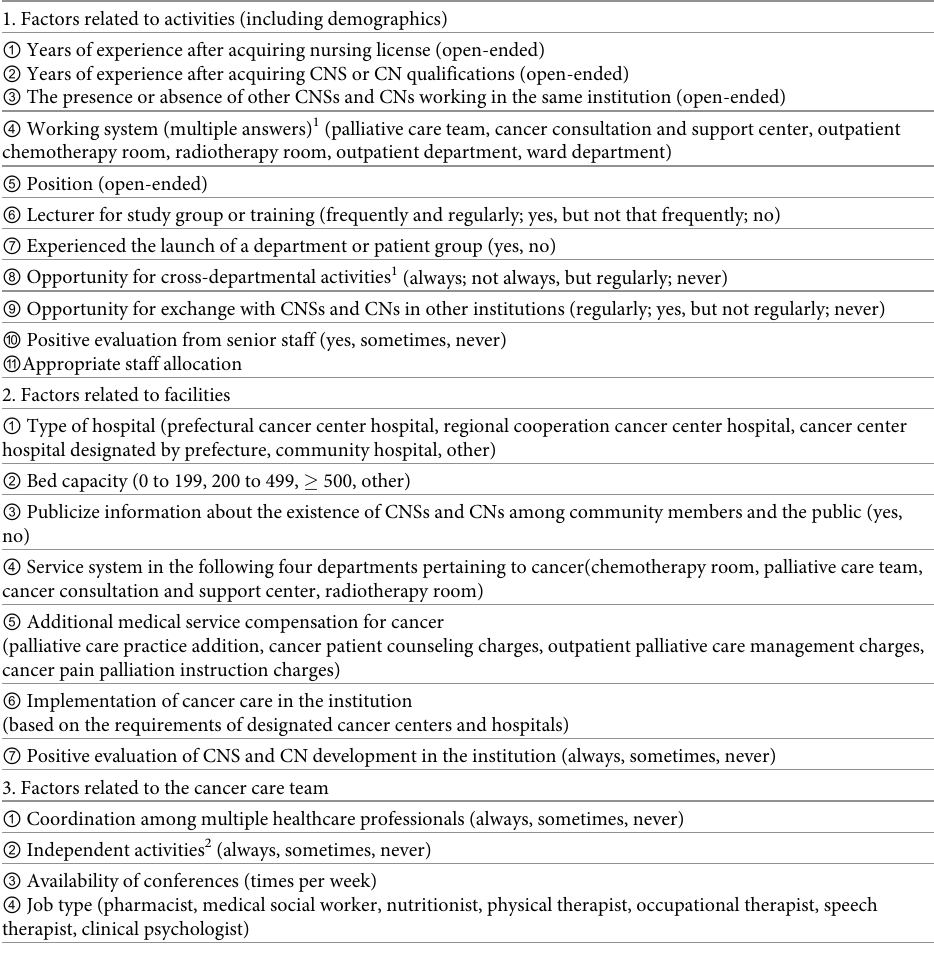
Table 1. Contents of the